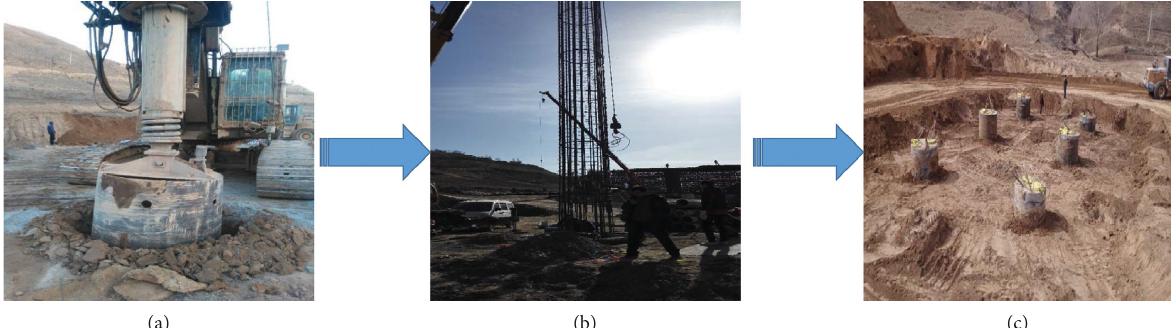
Figure 5: Construction of test piles and anchor piles. (a) Rotary drilling. (b) Lifting steel cage. (c) Test pile forming.